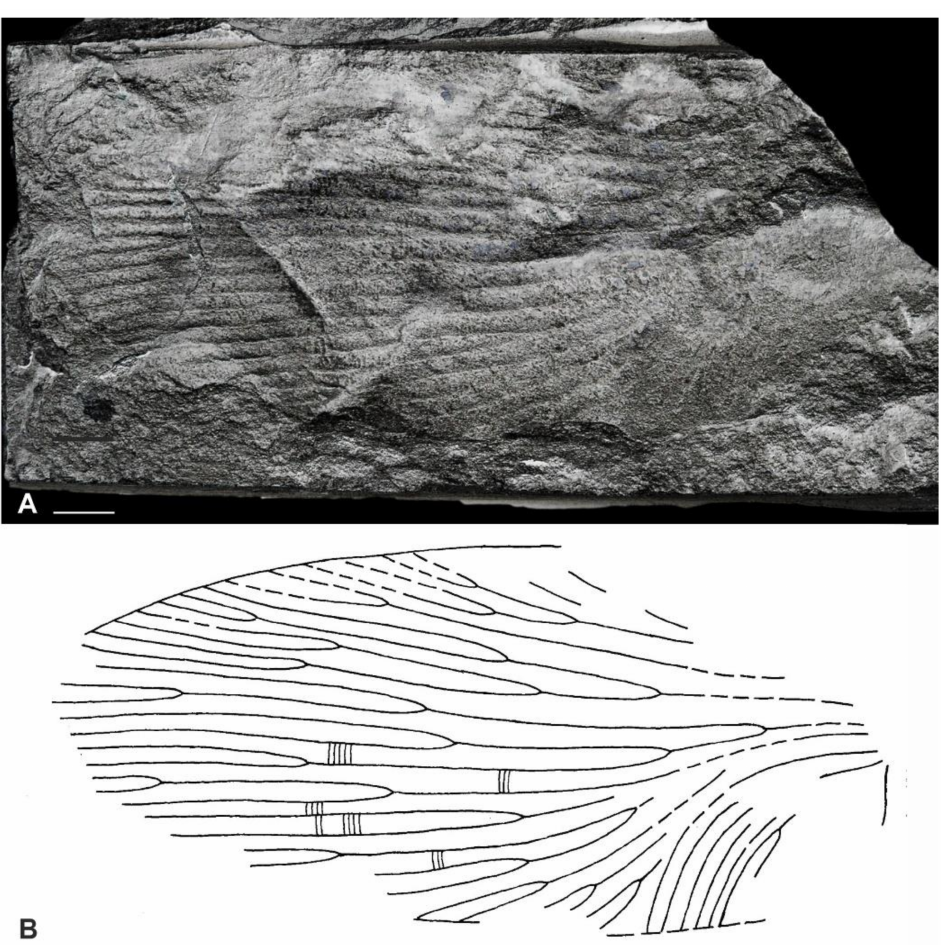
Figure 5. ( A , B )— Progonoblattina helvetica (Heer, 1864): type specimen of Blatta helvetica Heer, 1864, type species of Progonoblattina Scudder, 1879; Lower quarry of Erbignon; MGL.2551; reconstructed length 37 mm; scale bar 5 mm; photo: